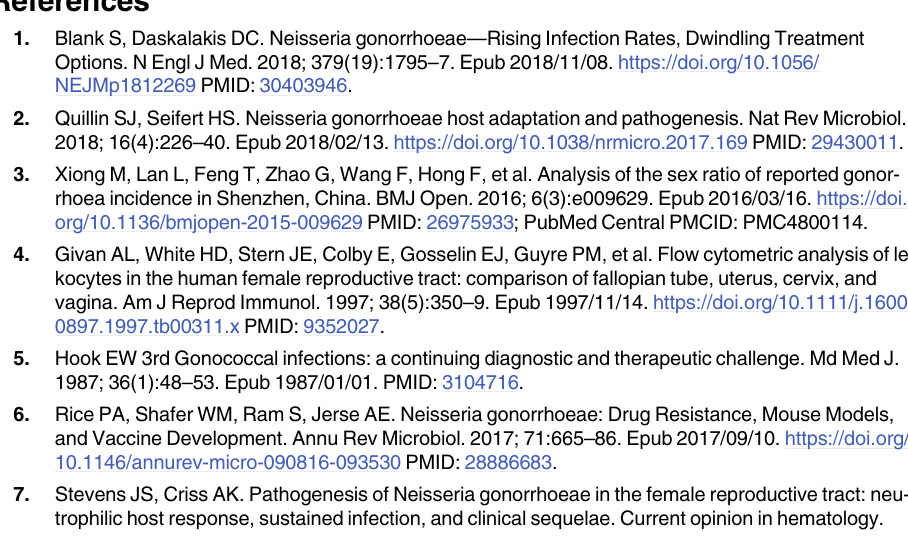
S2 Table. Guide RNAs used for U937 knockout (KO) lines. Guide RNAs used for formins, ACTR2 and CEACAM1 U937 KO lines are presented. The guide RNAs were cloned into lenti- Guide-Puro (Addgene plasmid